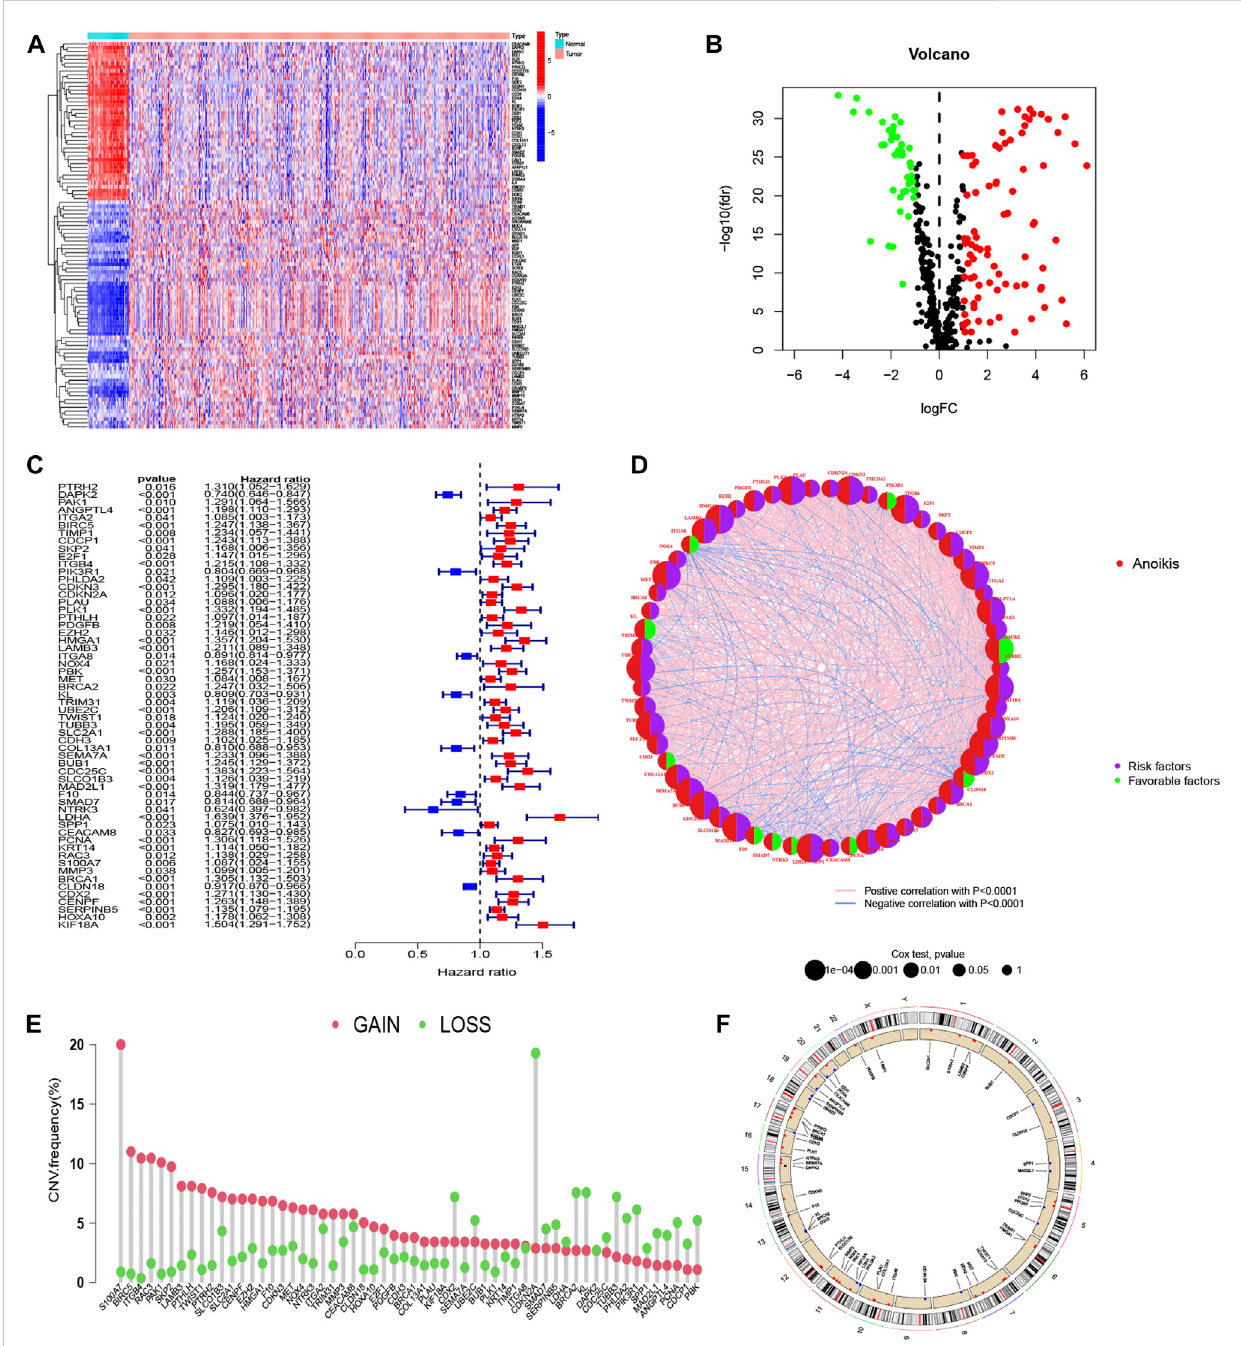
FIGURE 1 Acquisition of ARGs and CNV analysis. (A, B) Different expression of ARGs in LUAD with established standards (|log2FC| > 1 and FDR < 0.05). (C, D) Forest plot and network graph of identi fi ed 58 ARGs correlated with prognosis via univariate Cox regression analysis. The signi fi cance criteria were set as p -value < 0.05. (E) The CNV frequency of gaining or losing in each ARGs. (F) Location and copy number of ARGs on chromosomes presented by CNV cycle diagram. Red spots mean gain, accordingly, blue one means